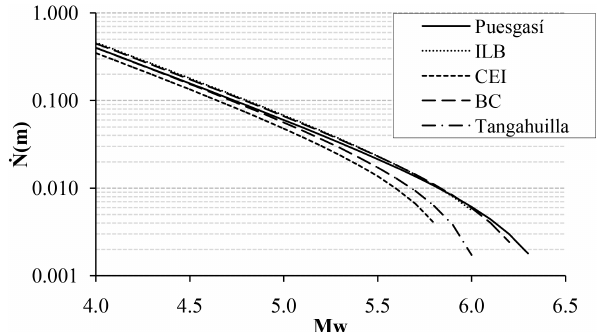
Figure 9. Earthquake cumulative rate for different magnitudes ˙ N(m) (Rivas-Medina et al.,